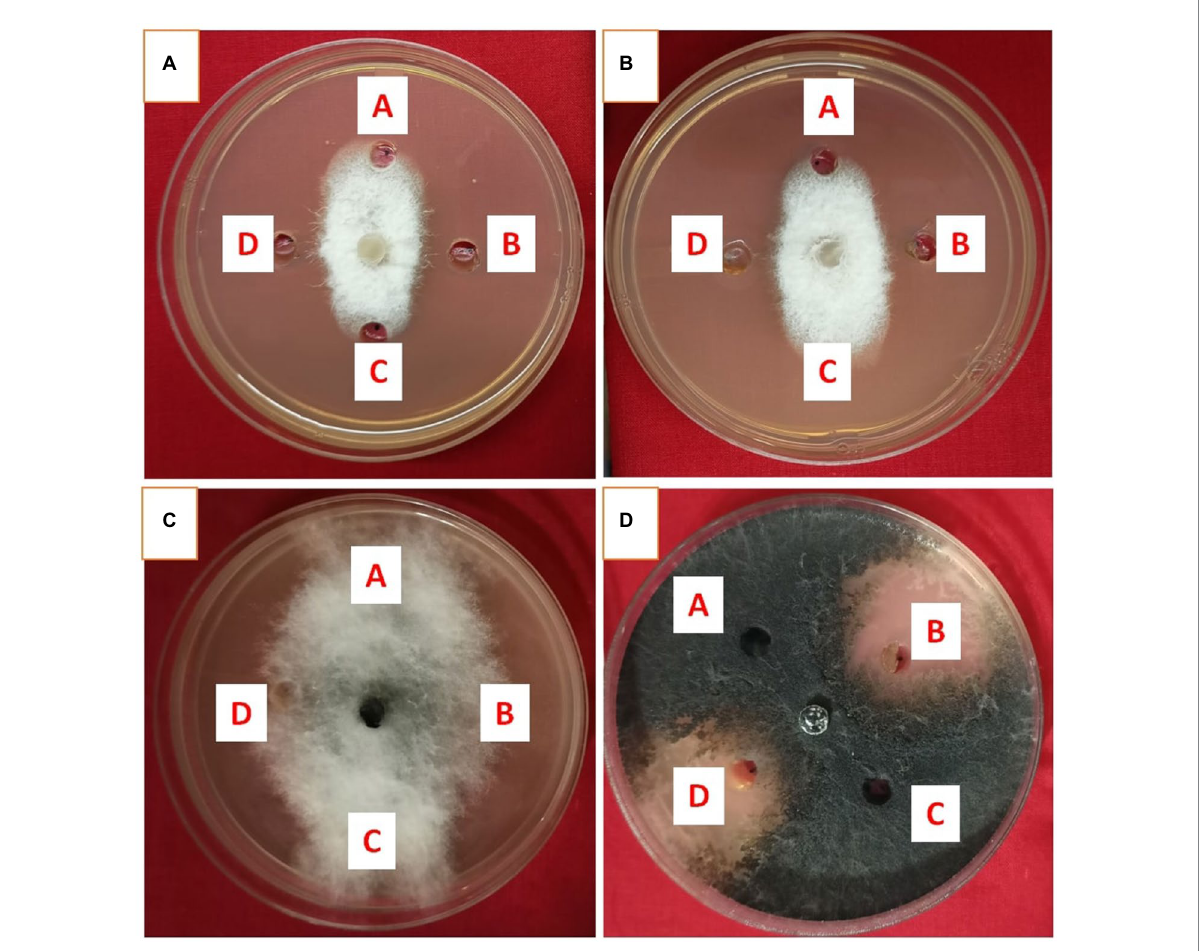
FIGURE 4 Antifungal activity of ethyl acetate extract of Streptomyces araujoniae TN11 in well diffusion assay against fungal pathogens Fusarium udum (A) , Fusarium oxysporum (B) , Macrophomina phaseolina (C) and Sclerotinia sclerotiorum (D) . Well A = Control, C = solvent control, B and D = ethyl acetate extract (20 μ